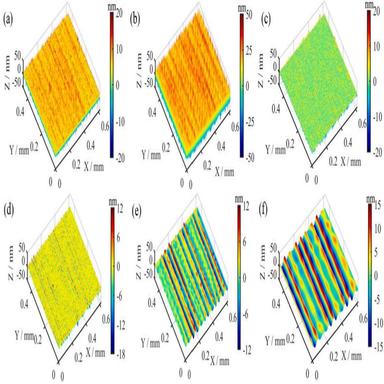
(a–f) are the surface texture within the 1st to the 6th scales at the machining condition II of, respectively.